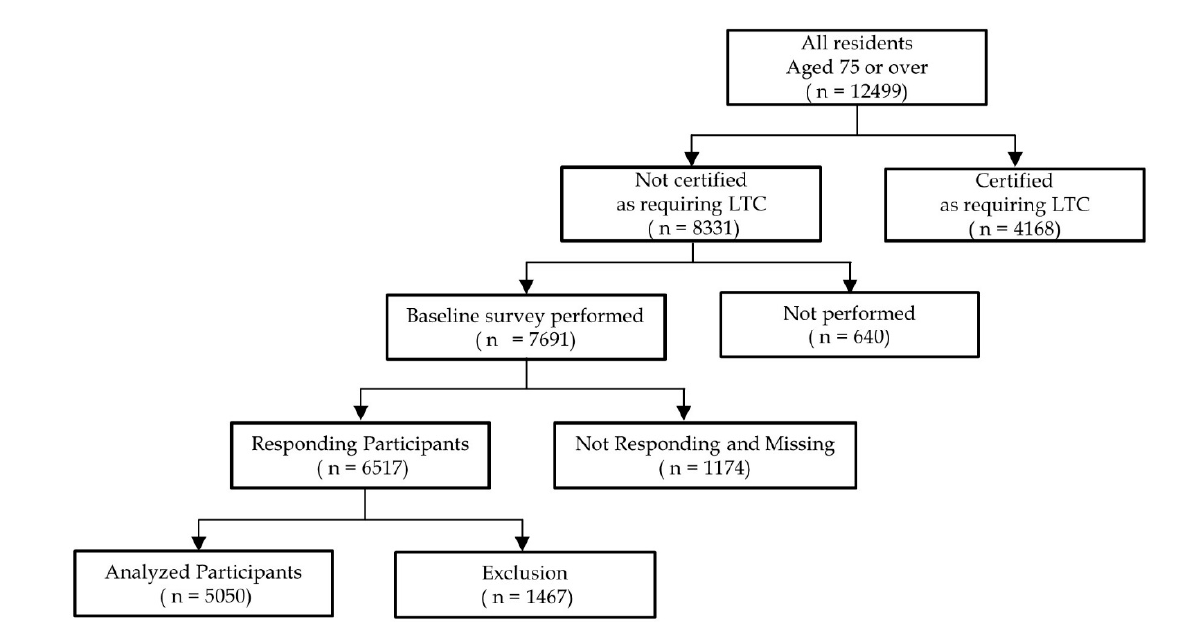
Figure 1. A flow chart of participants in the study cohort. LTC; long-term care.